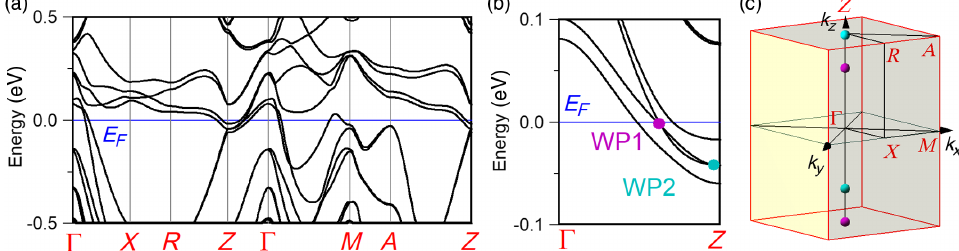
¼ ð 0 ; 0 ; 0 . 492 Þ 2 π =a (chiral negative, energy is − 5 meV) and k F WP 2